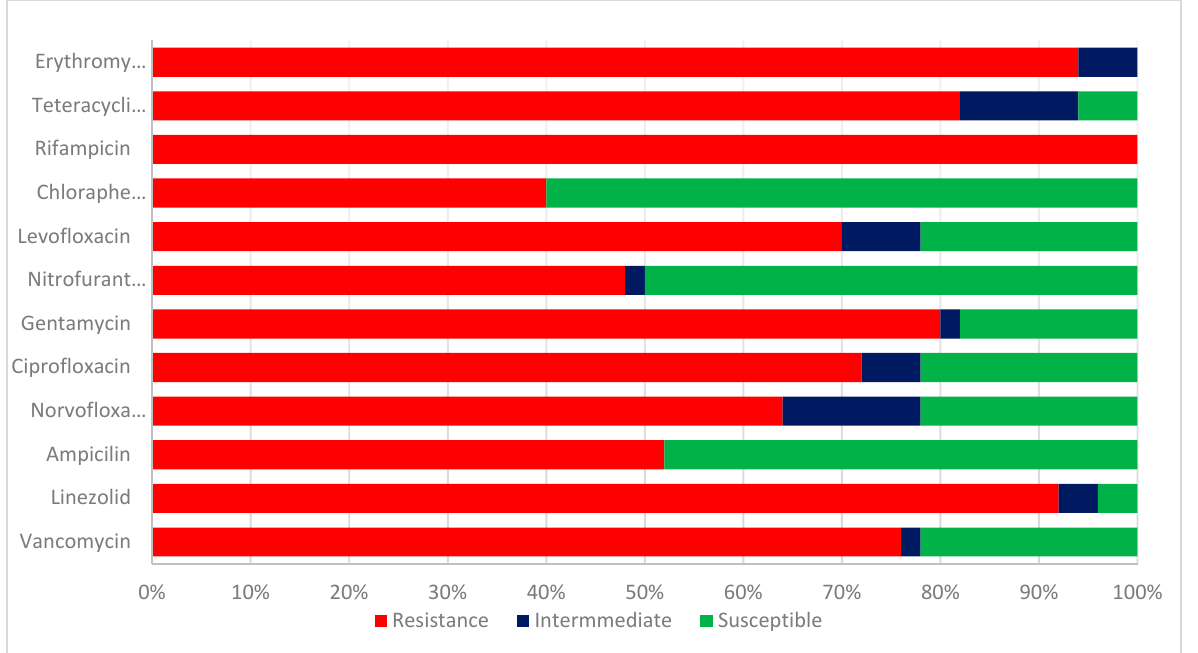
Table 1. A link between the antibiotic profiling and class 1 integrons in Enterococcus strains.